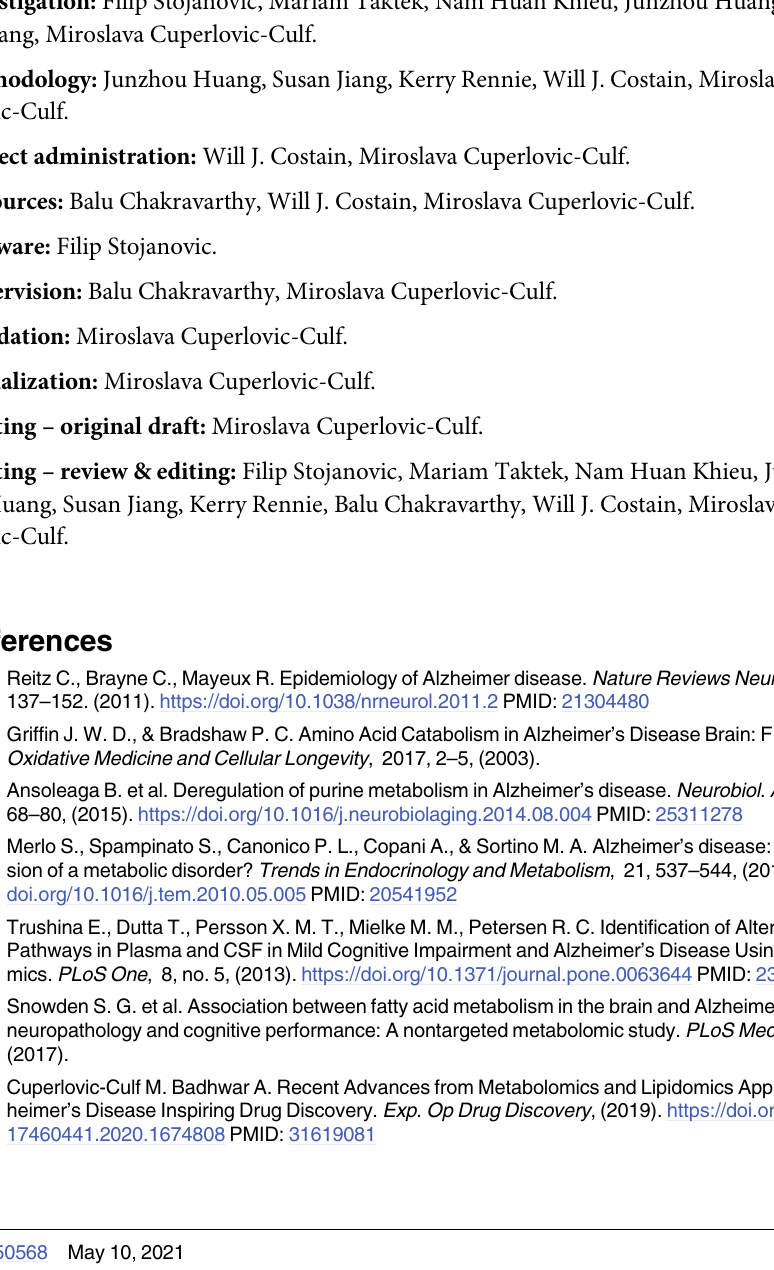
S2 Fig. Average value of metabolites with standard deviation determined in Blood samples determined from CPMG experiment. Shown are values prior to